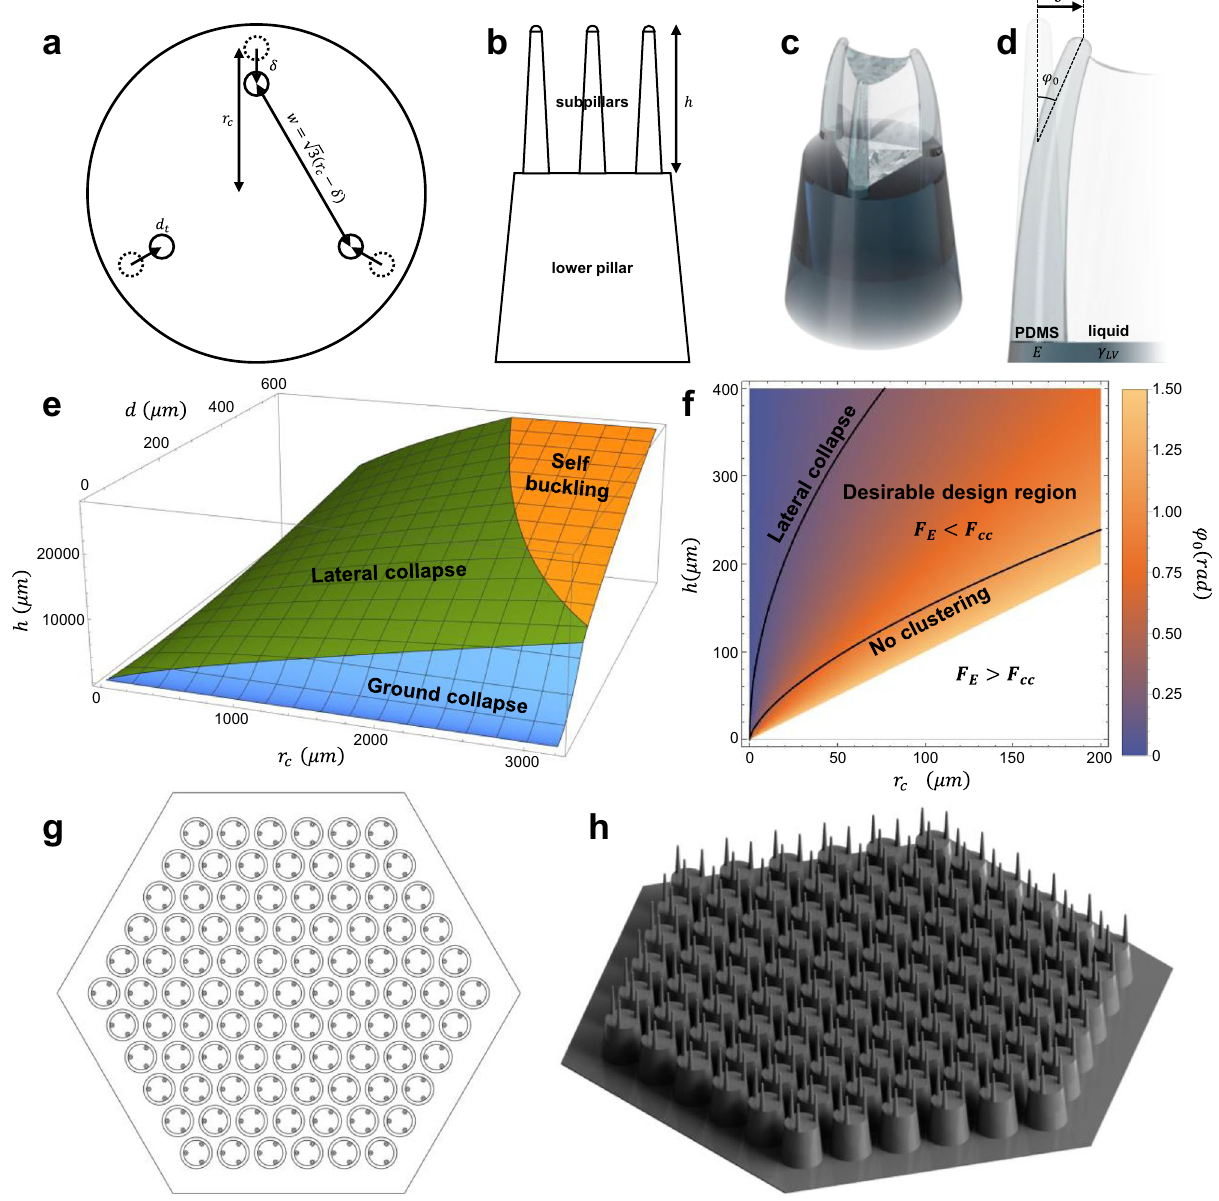
Fig. 2 | Design of the master mold. a , b Schematics of major design variables for CFIC, where d t is the micropillar tip diameter, h is the height of the subpillar, r c is the center-to-center radius, and δ is the de fl ection of a pillar. c , d Schematics of a hierarchicalpillarbeingbenttocapillaryinteractionforcewhenpartiallyimmersed in a liquid. e Three-dimensional plot of the critical conditions for each collapse